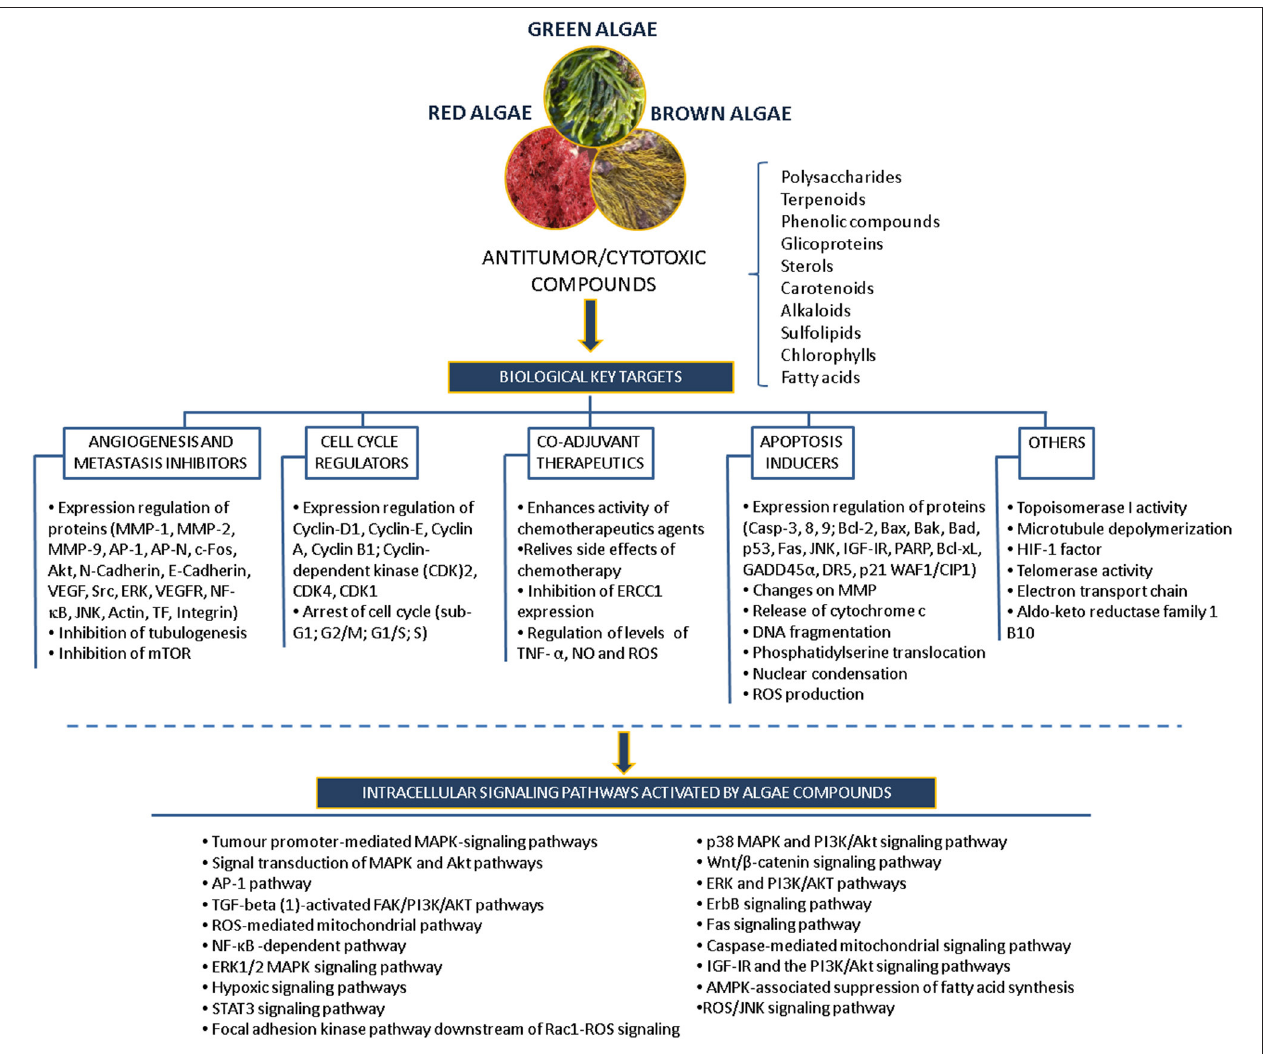
FIGURE 5 | Overview of the antitumor/cytotoxic compounds isolated from algae, biological targets and intracellular signaling pathways activated.